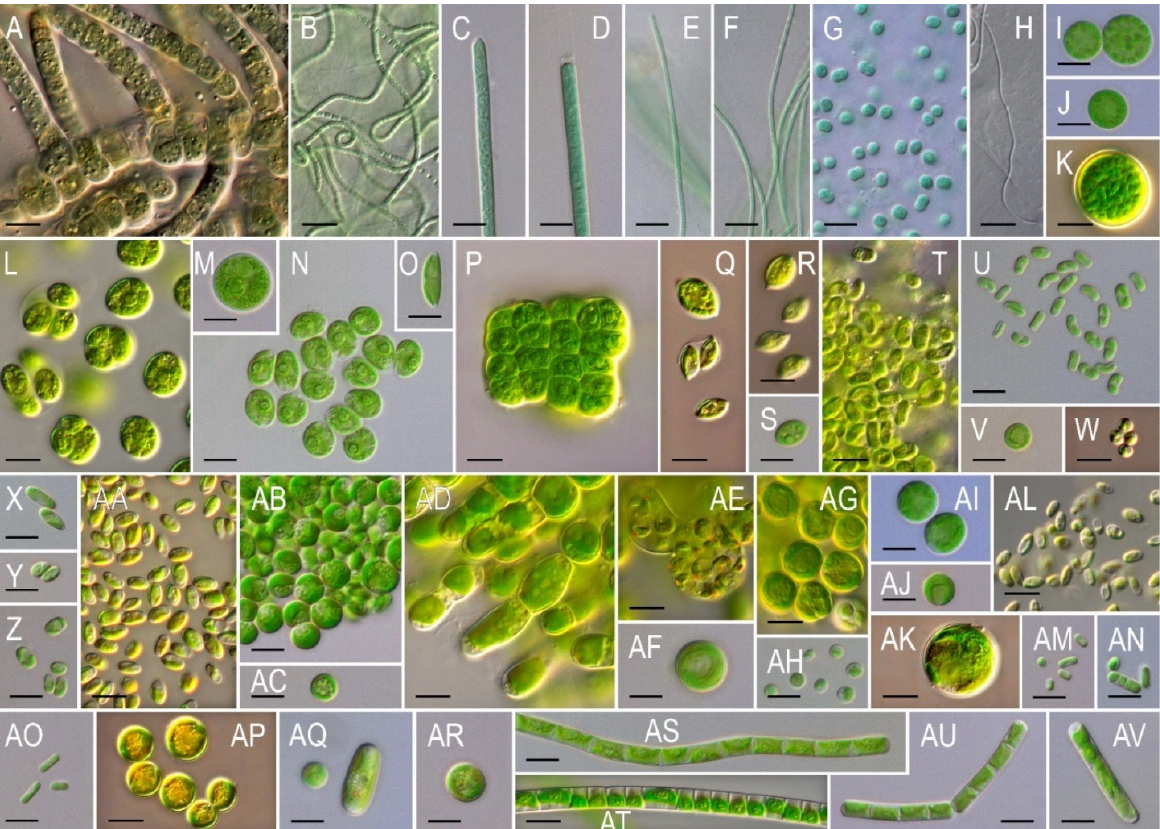
Figure 3. Algae and cyanobacteria from Mutnovsky and Gorely volcano soils: ( A ) Fischerella cf. major ; ( B ) Leptolyngbya cf. foveolarum ; ( C ) Microcoleus cf. calidus ; ( D ) Phormidium cf. corium ; ( E ) Stenomitos tremulus ; ( F ) Stenomitos sp ; ( G ) Synechocystis cf. salina ; ( H ) cf. Trichocoleus hospitus ; ( I ) Bracteacoccus bullatus ; ( J ) Bracteacoccus minor ; ( K ) Bracteacoccus sp. 1; ( L ) Chlamydocapsa cf. lobata ; ( M ) Chlorococcum hypnosporum ; ( N ) Chlorococcum lobatum ; ( O ) Chlorolobion cf. lunulatum ; ( P ) Chlorosarcinopsis sp.; ( Q ) Coelastrella aeroterrestrica , strain C_aero; ( R ) Coelastrella oocystiformis , surface view; ( S ) Coelastrella terrestris , median view; ( T ) Neocystis mucosa , strain K2 N_muc; ( U ) Neocystis mucosa , strain 1272; ( V ) Chlorella cf. chlorelloides ; (W) Chlorella sp. 2; ( X ) Coccomyxa subellipsoidea ; ( Y ) cf. Coccomyxa viridis ; ( Z ) Coccomyxa sp. 2., strain 1237; ( AA ) Coccomyxa sp. 1; ( AB ) Elliptochloris cf. reniformis ; ( AC ) Elliptochloris cf. subsphaerica ; ( AD ) Leptosira obovata , vegetative cells; ( AE ) Leptosira obovata , zoosporangium; ( AF ) Lobosphaera incisa , strain 1248; ( AG ) Lobosphaera sp.; ( AH ) Micractinium sp; ( AI ) Myrmecia sp. 1; ( AJ ) Parietochloris pseudoalveolaris , strain 1306; ( AK ) Parietochloris sp.; ( AL ) Pseudococcomyxa sp.; ( AM ) Stichococcus sp. 1; ( AN ) Stichococcus sp. 2; ( AO ) Stichococcus sp. 3; ( AP ) Vischeria magna ; ( AQ ) Vischeria cf. stellata ; ( AR ) Vischeria sp.; ( AS ) Klebsormidium nitens ; ( AT ) Klebsormidium sp. 1; ( AU ) Klebsormidium sp. 2; ( AV ) Mesotaenium sp. Scale bar: 10 μ m.